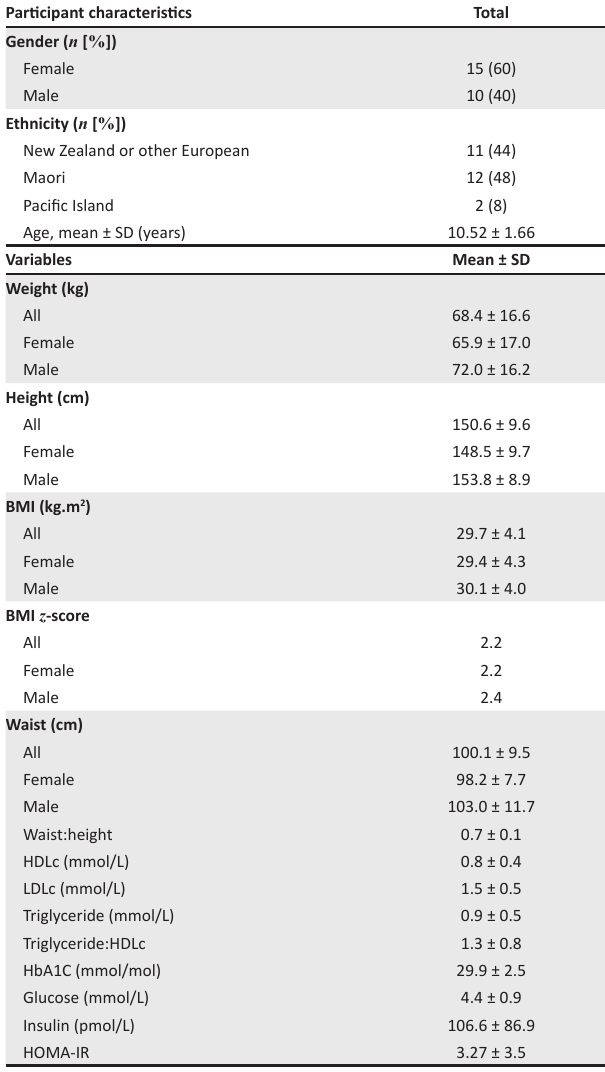
TABLE 1: Baseline participant characteristics and blood marker